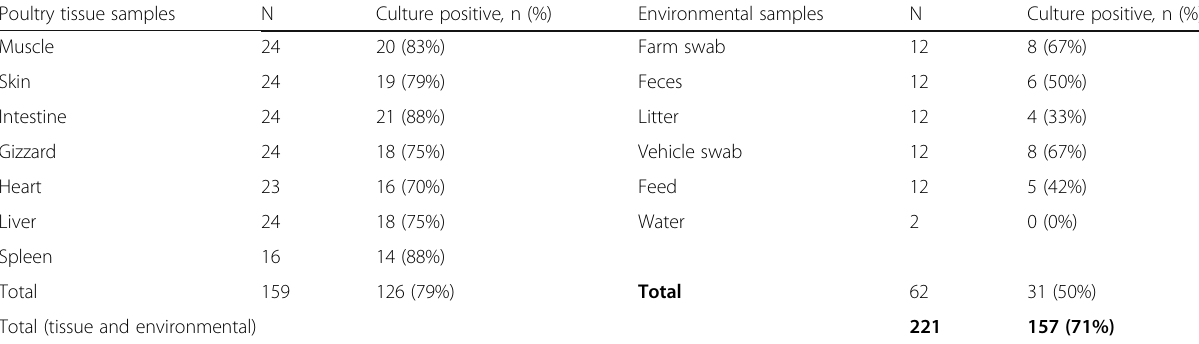
Table 1 Percentage of Salmonella enterica culture positivity by sample types Poultry tissue samples